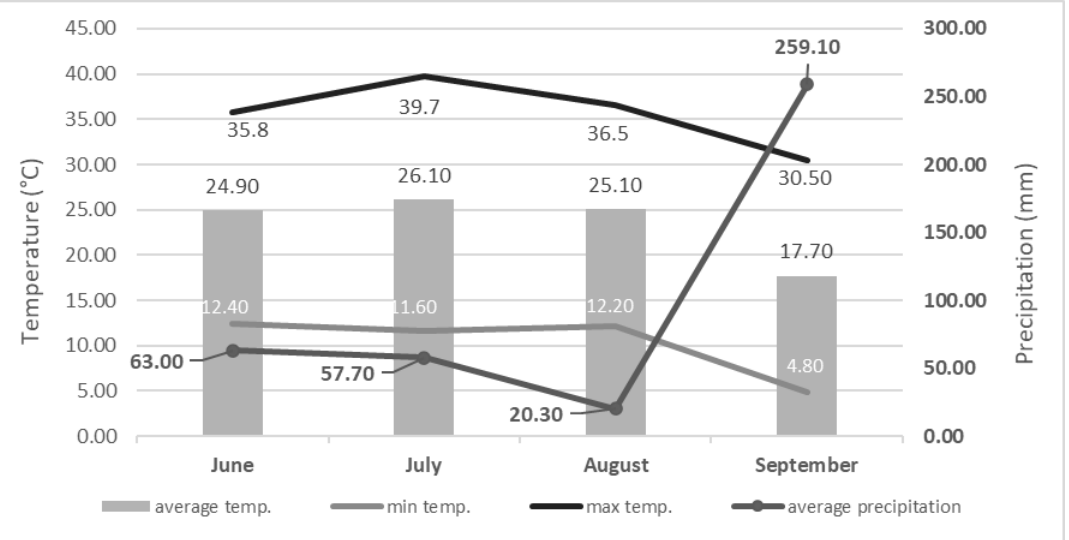
Figure 1. Dry matter content (%) of leaves of Virginia mallow and cup plant at different phenophase. Ph1—pre-flowering, Ph2—full flowering, and Ph3—end of flowering. Different letters indicate significant differences between means at p ≤ 0.0001.